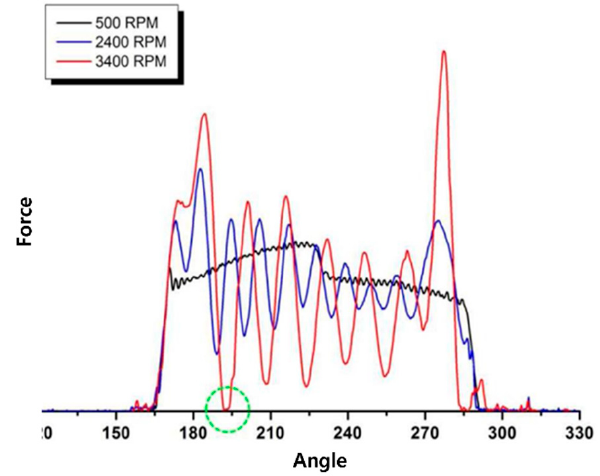
Figure 2. Contact loss in the diesel engine valve